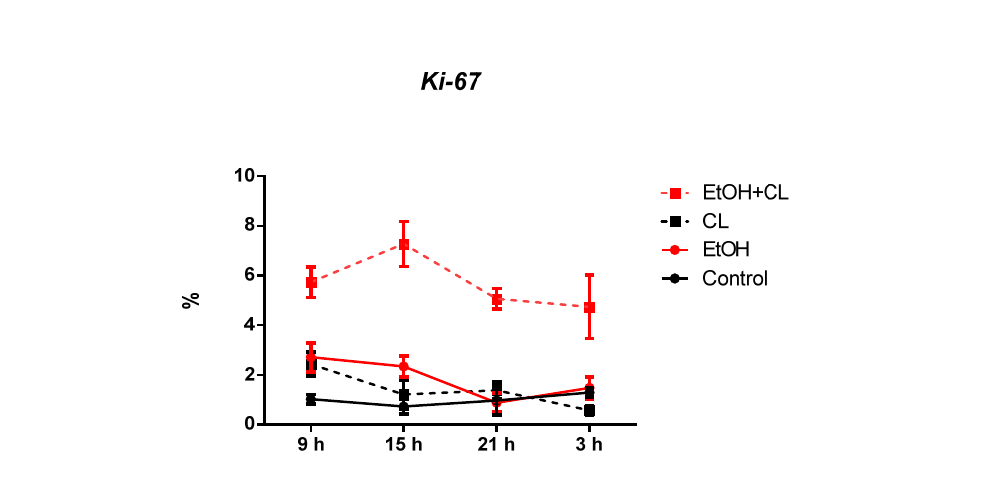
Figure 16. Daily dynamics of Ki-67 expression in hepatocytes of rats. Table 3. Results of the cosinor analysis of the daily dynamics of the expression of the studied